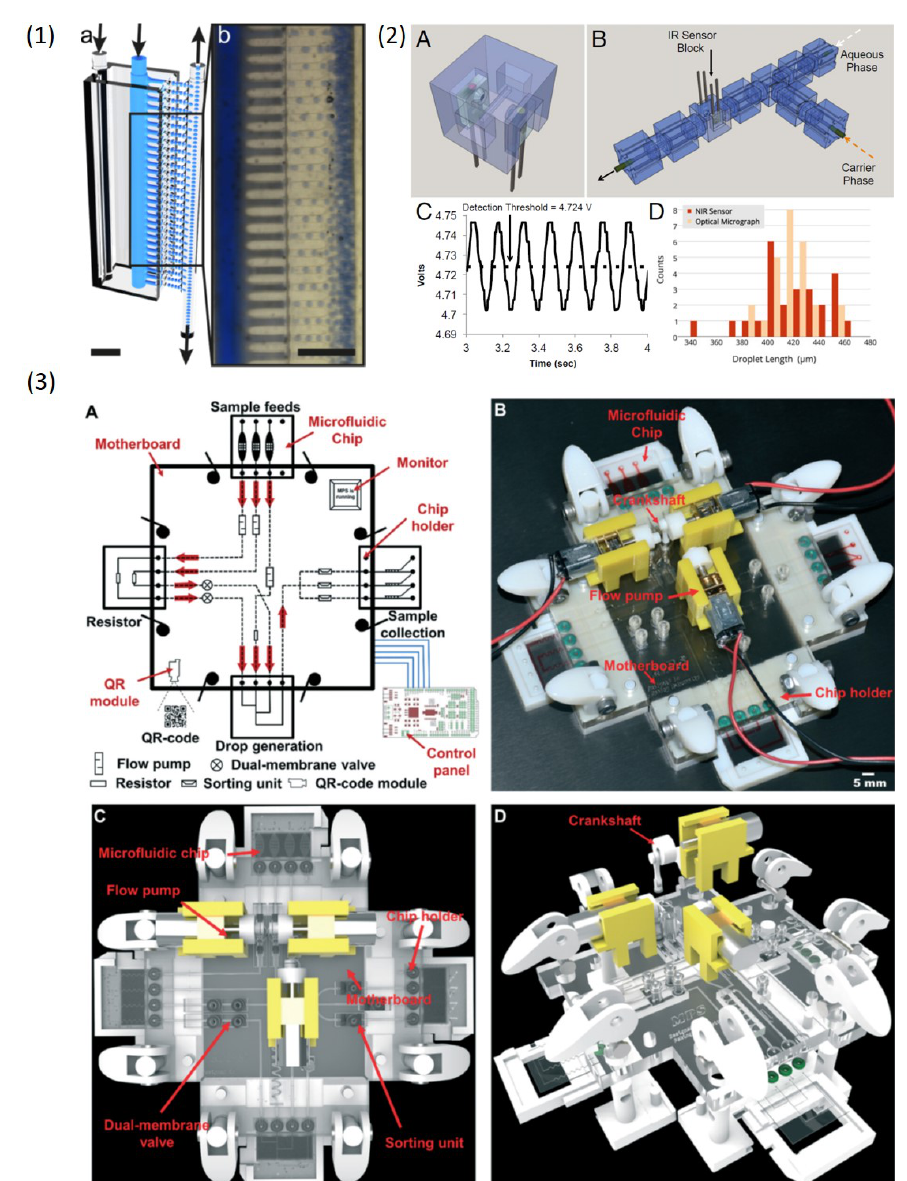
Figure 10. ( 1 ) 3D-printed parallel flow-focusing structures for high throughput production of emulsions. ( 2 ) A near-infrared sensor embedded on a 3D-printed device to monitor droplet generation. ( 3 ) An integrated milli/microfluidic processing system printed by Polyjet including droplet generation, detection, sorting and collection. Reproduce of